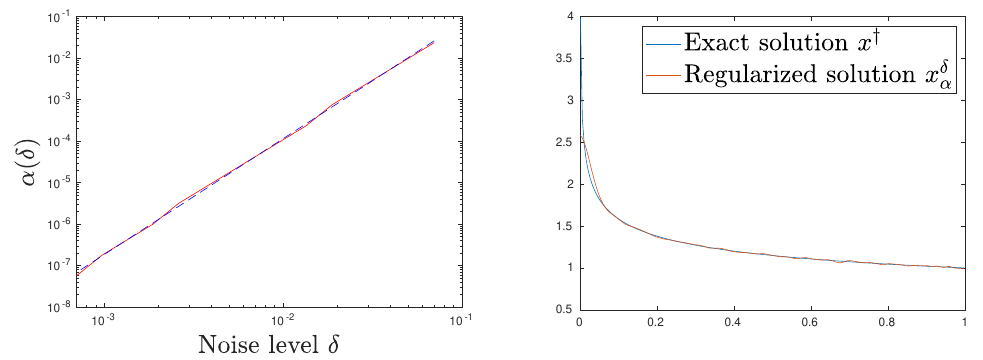
Figure 3. α discr ( δ , y δ ) in red for various δ and best approximating regression line in blue/dashed on a log-log scale ( left ). Regularized (red) compared with exact solution (blue) for δ = 10 − 3.5 ( right ).